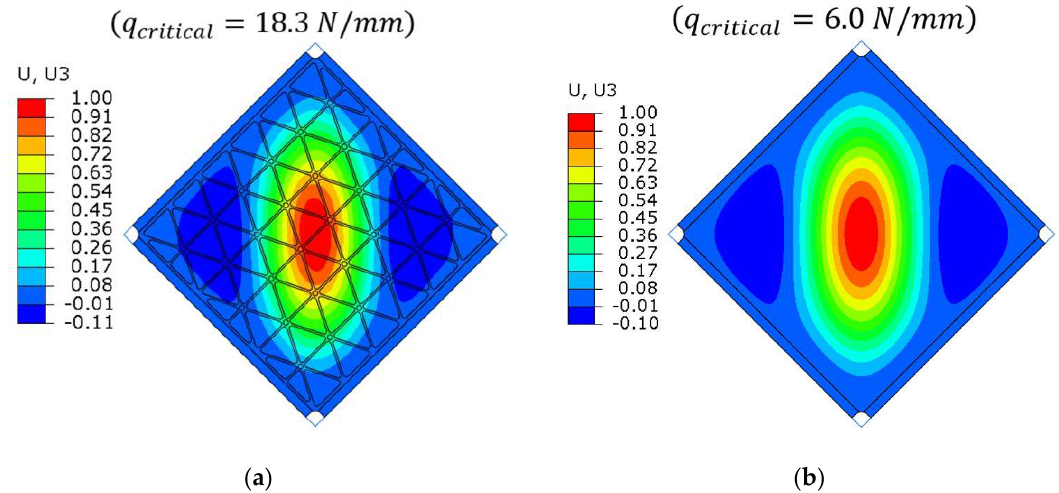
Figure 17. Results of linearized buckling FEM analyses. Normalized deflection fields for the first buckling modes for ( a ) the stiffened plate and ( b ) the smooth plate. The values given in parentheses mean the critical shear edge load corresponding to the first buckling mode. The shape of deformation used as geometrical imperfections in the first step of nonlinear FEM analyses.